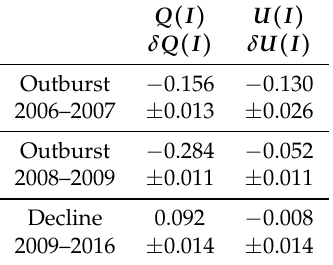
Table 4. The inclination angles for polarimetric